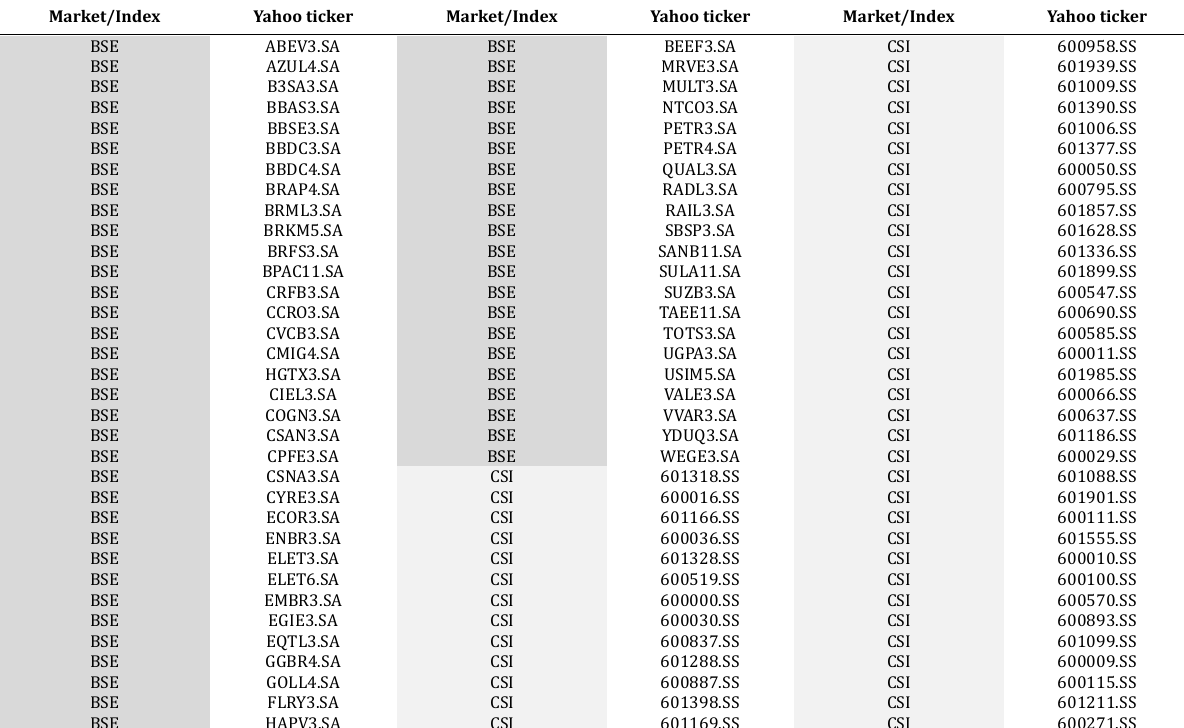
Table 1. The Yahoo ticker names of the stocks